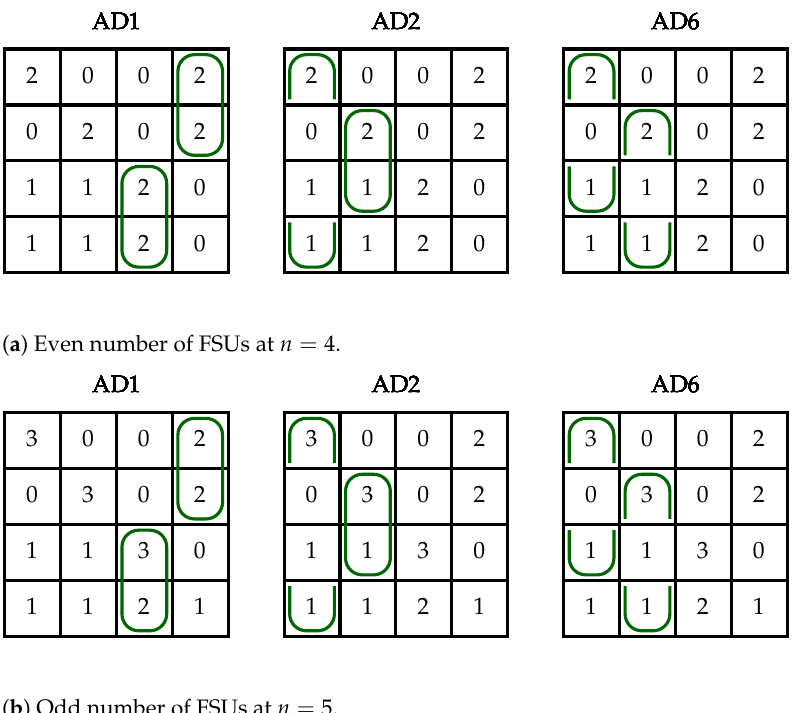
Figure 6. Example of applying AD2 and AD6 instead of AD1 to achieve lower value for k